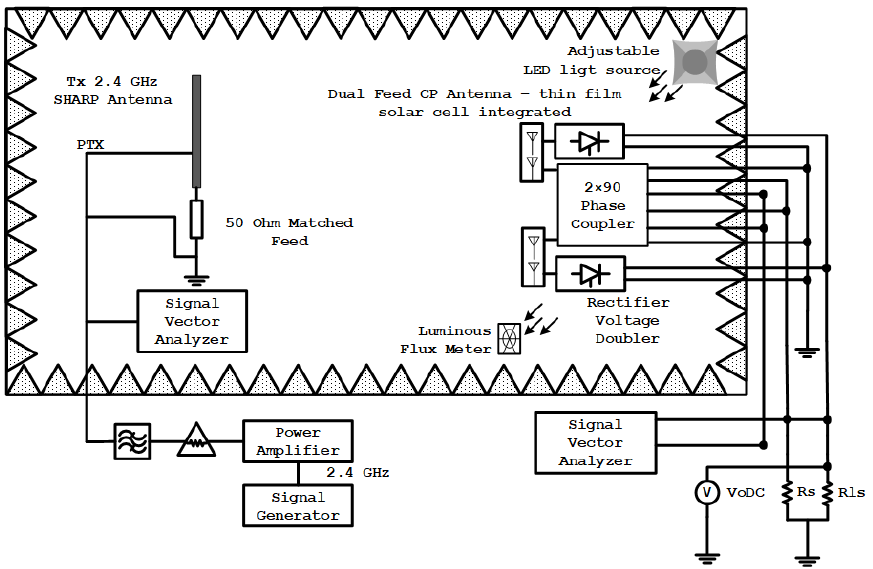
Figure 13. Configuration of the prototype circuit performance test.